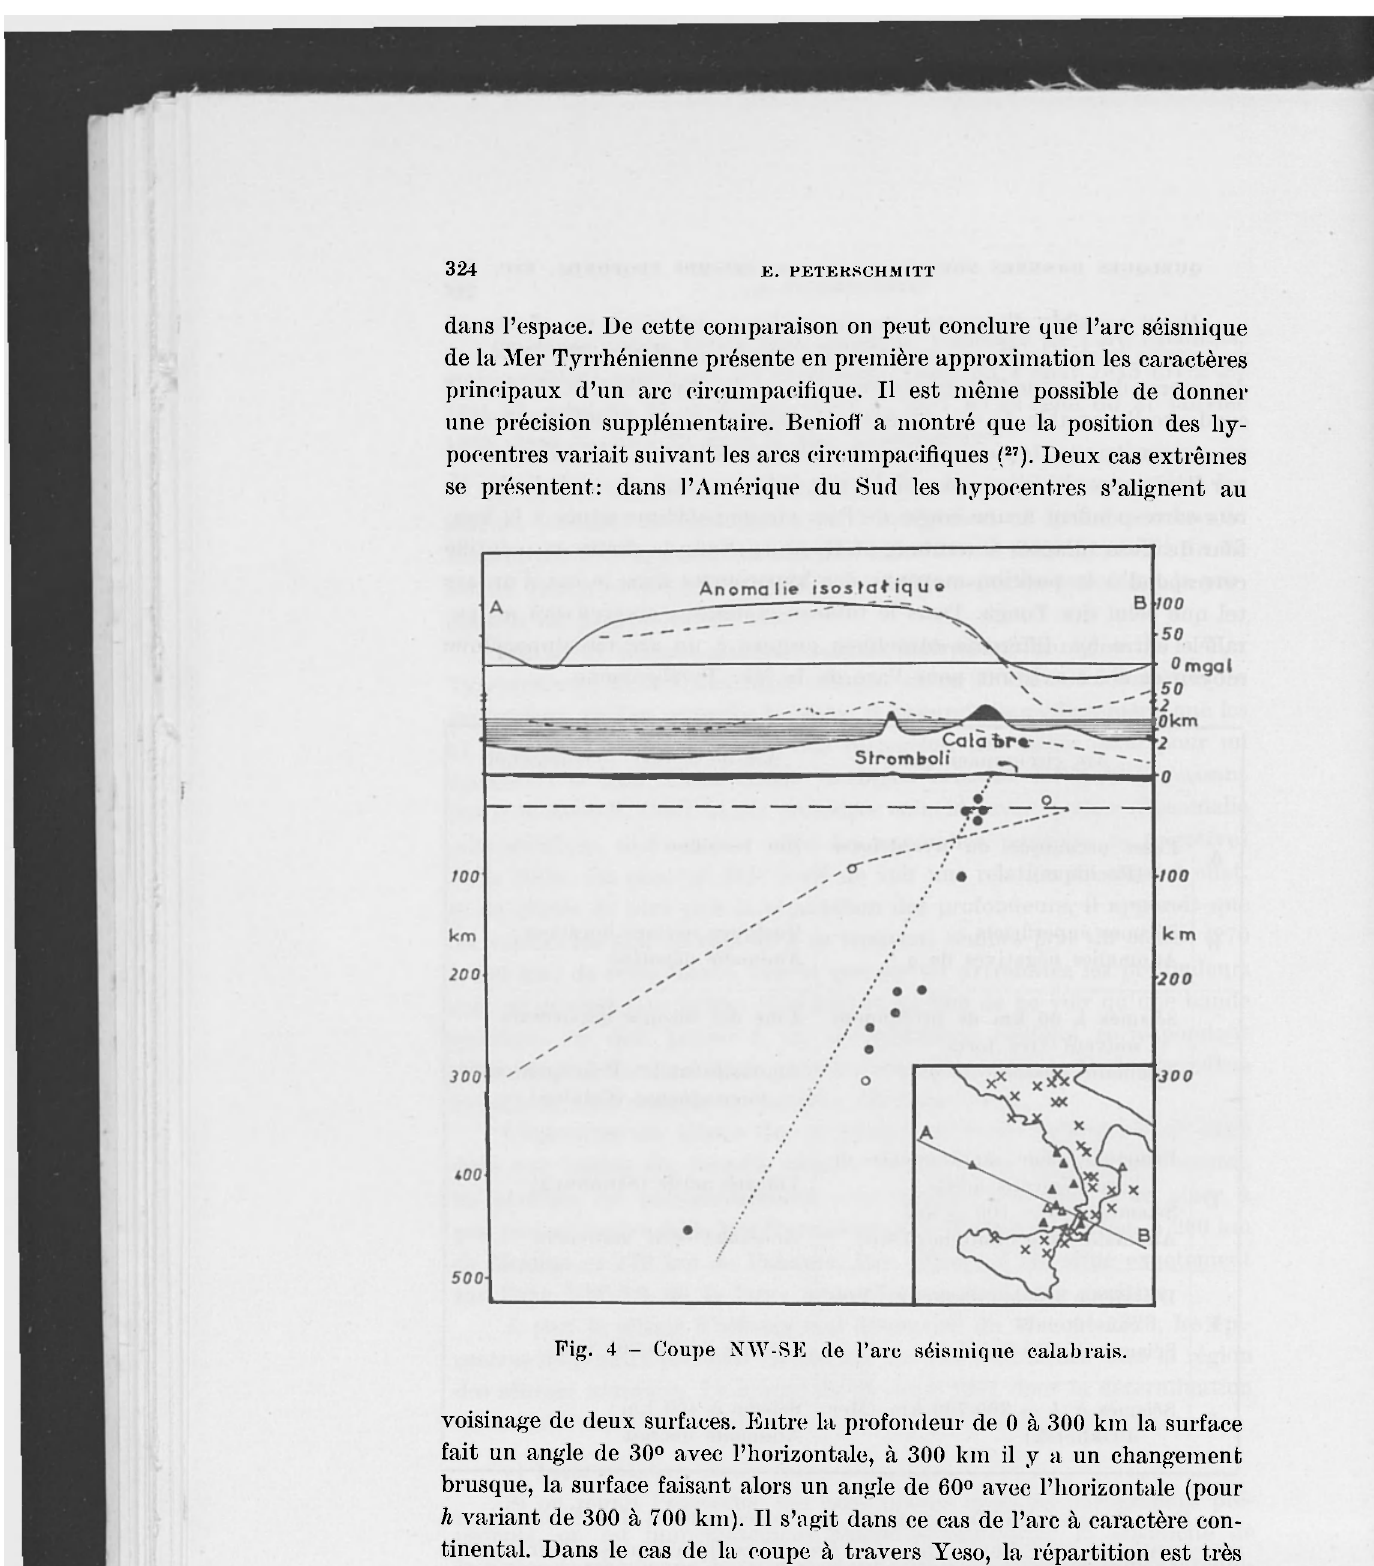
Fig. 4 - Coupé NW-SE de l'are séismique